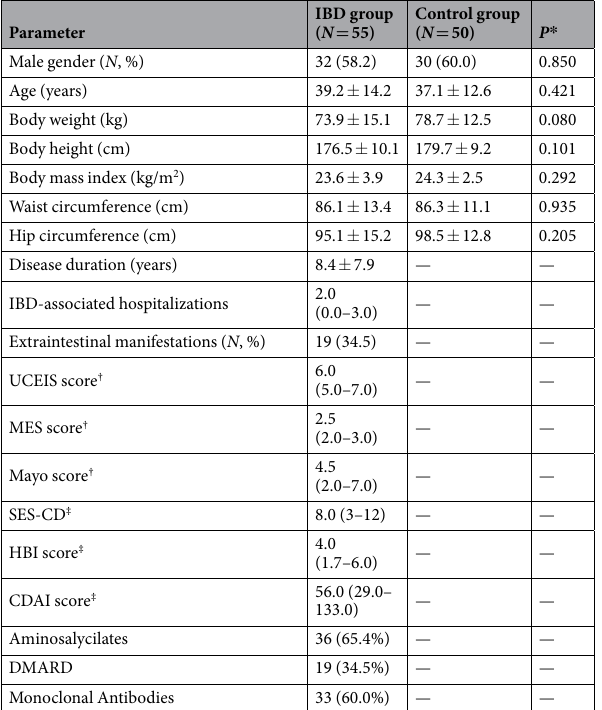
— — Table 1. Baseline characteristics of IBD patients and healthy controls. Abbreviations: UCEIS - Ulcerative Colitis Endoscopic Index of Severity; MES - Mayo Endoscopic Score; SES-CD - Simple Endoscopic Score for Crohn’s Disease; HBI - Harvey Bradshaw Index; CDAI - Crohn’s Disease Activity Index; DMARD - Disease-modifying antirheumatic drug. Data are presented as mean ± standard deviation or median (IQR). * chi-square test or t-test for independent samples. † Ulcerative colitis group ( N = 30). ‡ Crohn’s disease group ( N = 25).